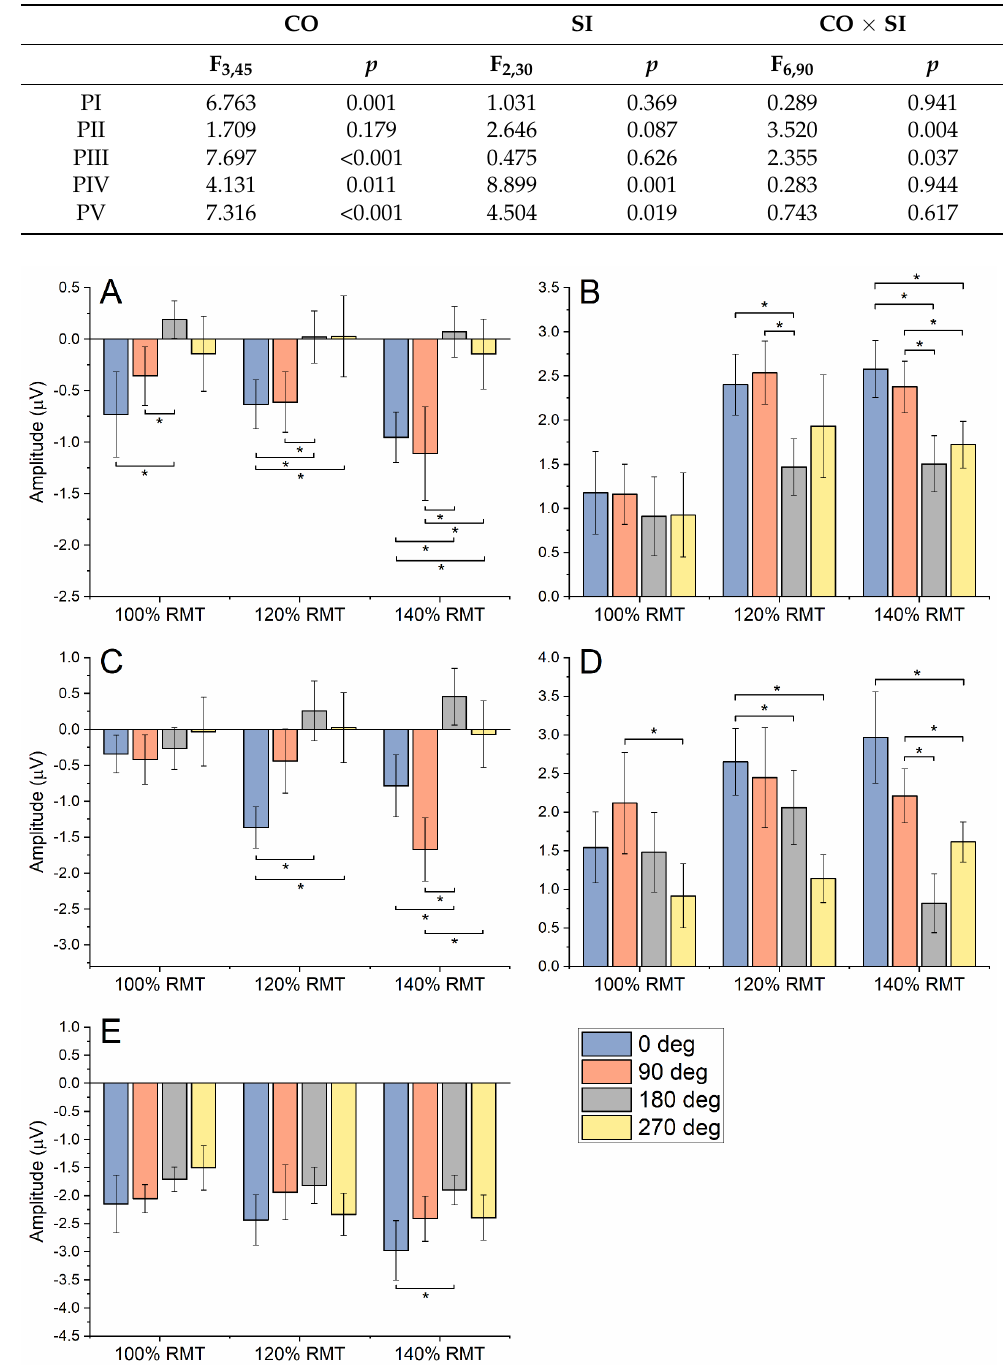
Table 2. Summary statistics of the ANOVAs on TEP peaks.